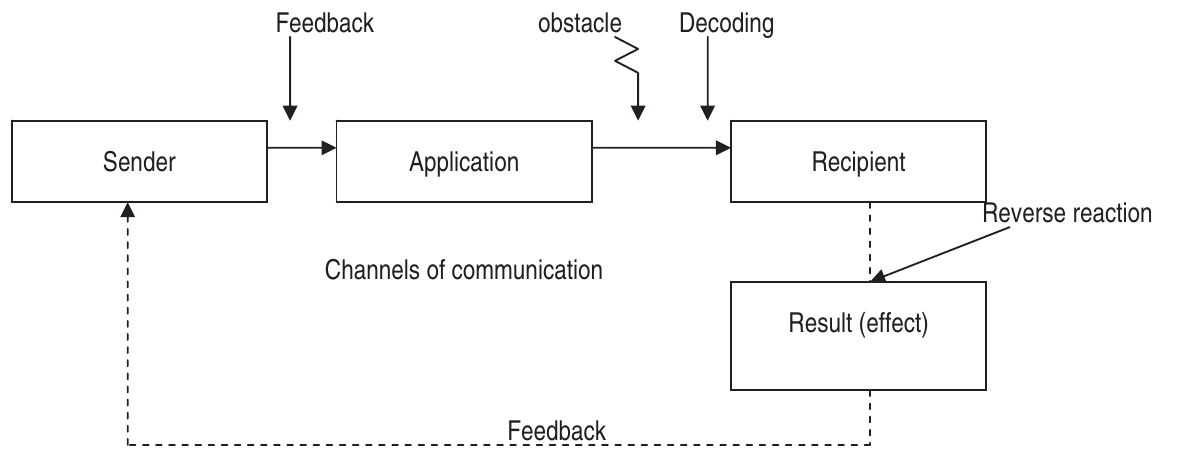
Fig. 2. Customer attraction layout